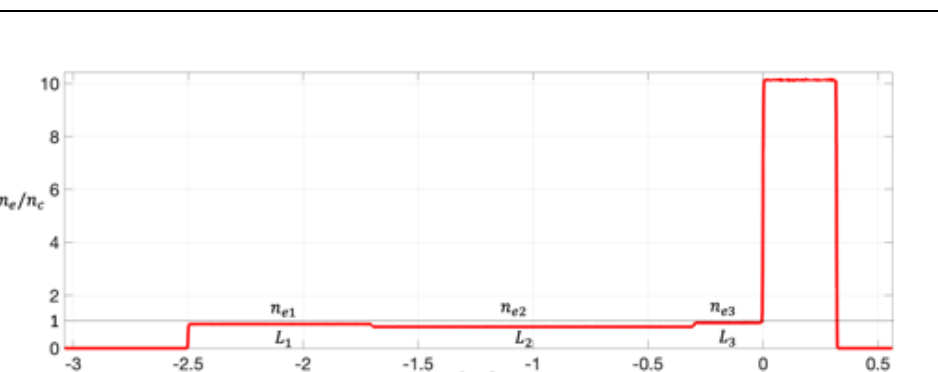
Figure 1. Density profile showing the shape of the tailor region and the foil. Inset shows the 6 free parameters to vary in addition to the foil density and thickness. The value of parameters shown is for the best-case scenario.